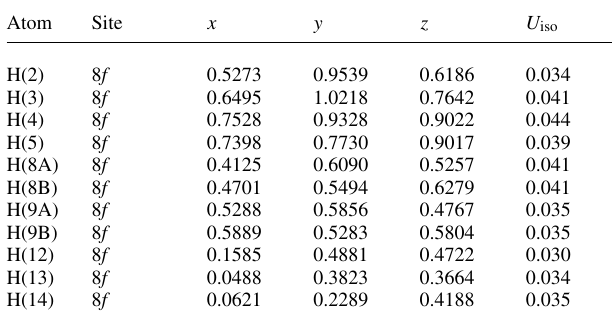
Table 2. Atomic coordinates and displacement parameters (in Å 2 )